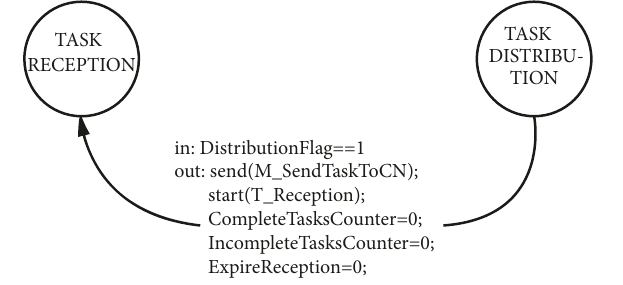
Figure 7: Transition from TASK DISTRIBUTION to TASK RECEPTION state.